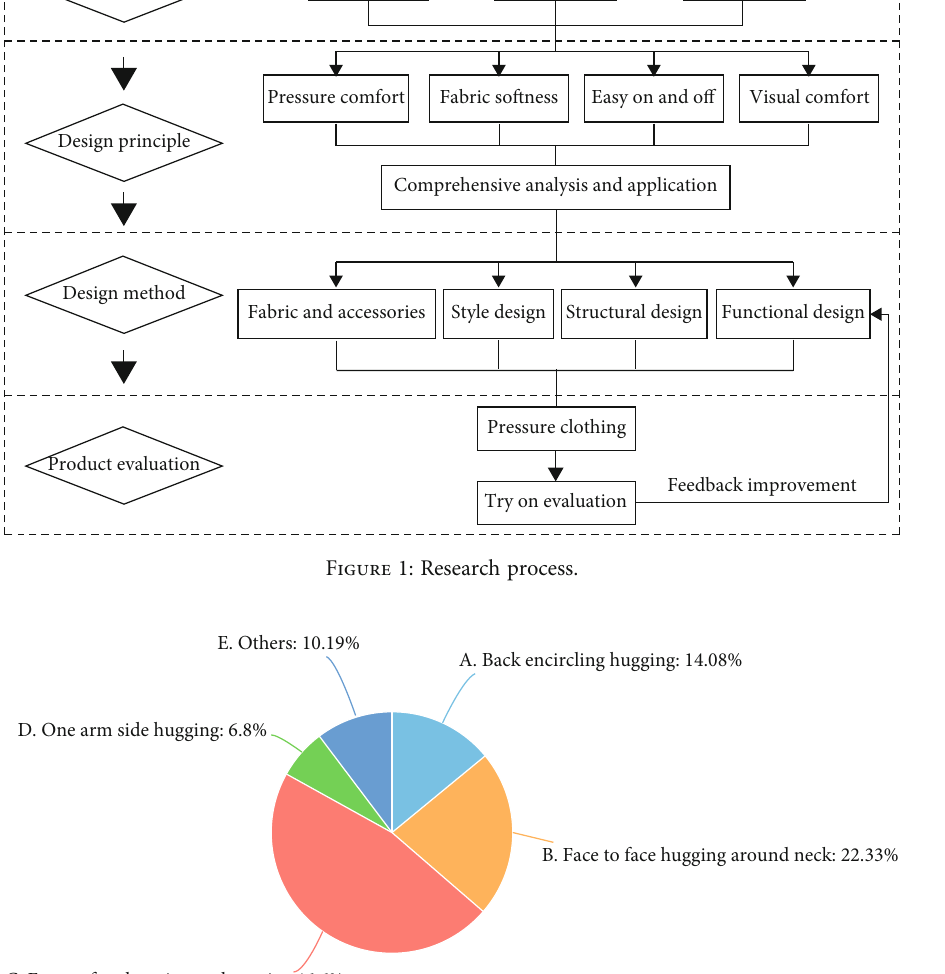
Figure 2: Analysis results of “ hug posture preference.